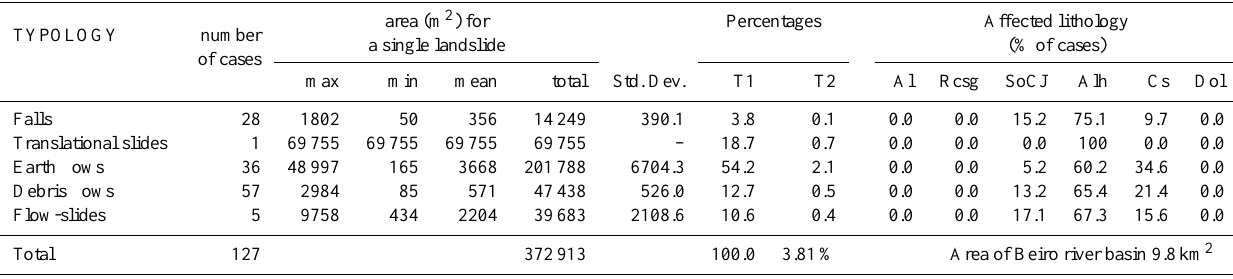
Fig. 3. Landslide inventory. Spatial distribution of landslide, obtained for the Beiro river basin by Google EarthTM remote analysis. Coordinate Reference System: UTM zone 30 European Datum 50. Table 1. Landslide inventory, extension of landslide and lithology affected by slope